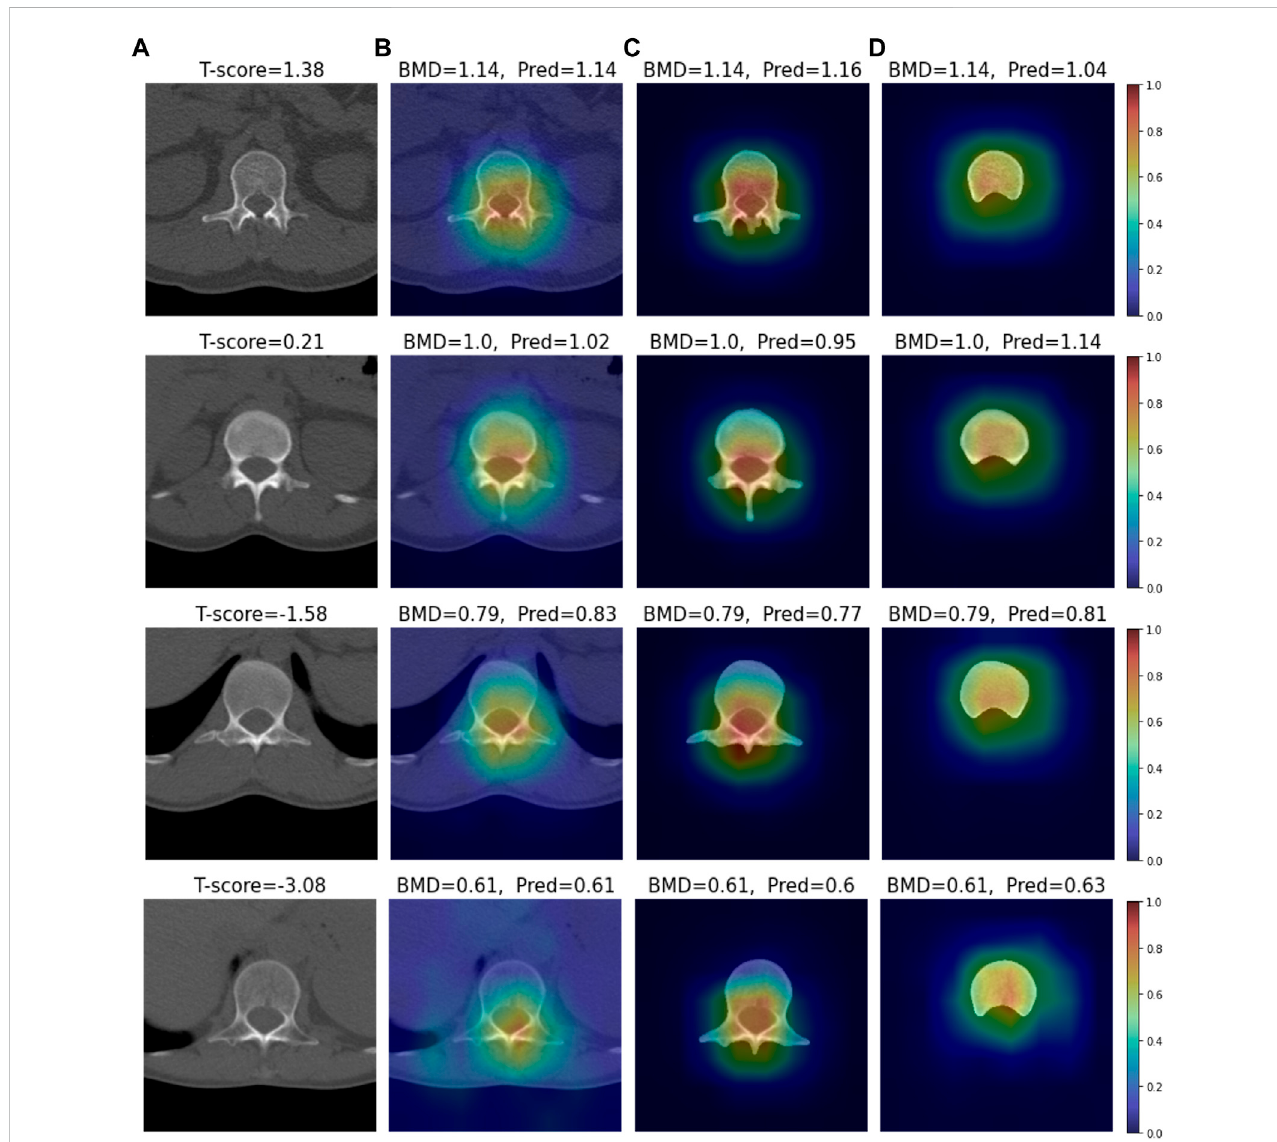
FIGURE 8 Visual XAI results (4 test samples) using Grad-RAMP. The results of every sample are represented by every row. Every row, (A) represents the cropped CT image.AT-scorevalueisplacedatthetopofeveryimage. (B – D) displaytheheatmapsuperimposedonthecroppedimageorbone-segmentedimage. (B – D) show Grad-RAMP results in Case 1, Case 2 and Case 3, respectively. “ BMD ” and “ Pred ” placed at the top of every image denote the reference and predicted values,